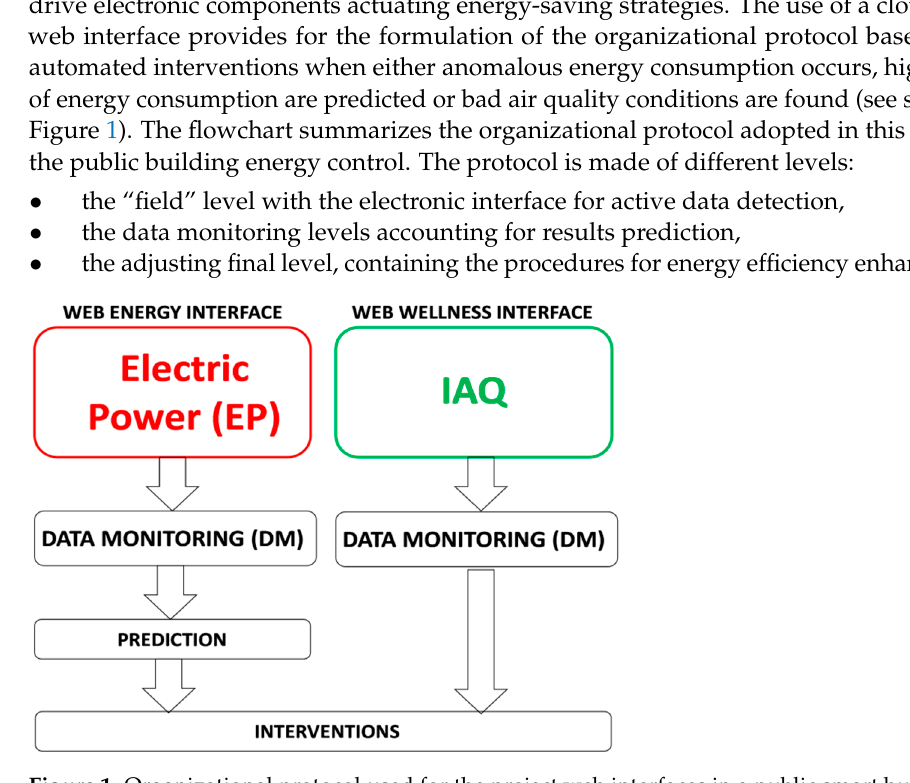
Figure 1. Organizational protocol used for the project web interfaces in a public smart building.